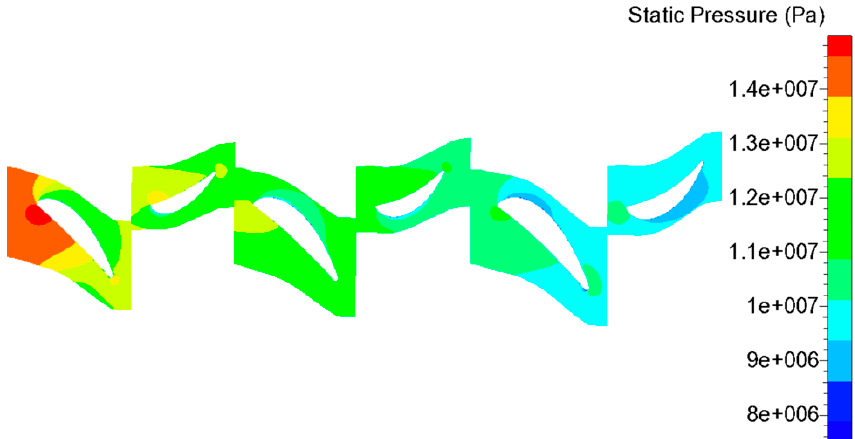
Figure 7. Pressure distribution at the 50% blade height section.